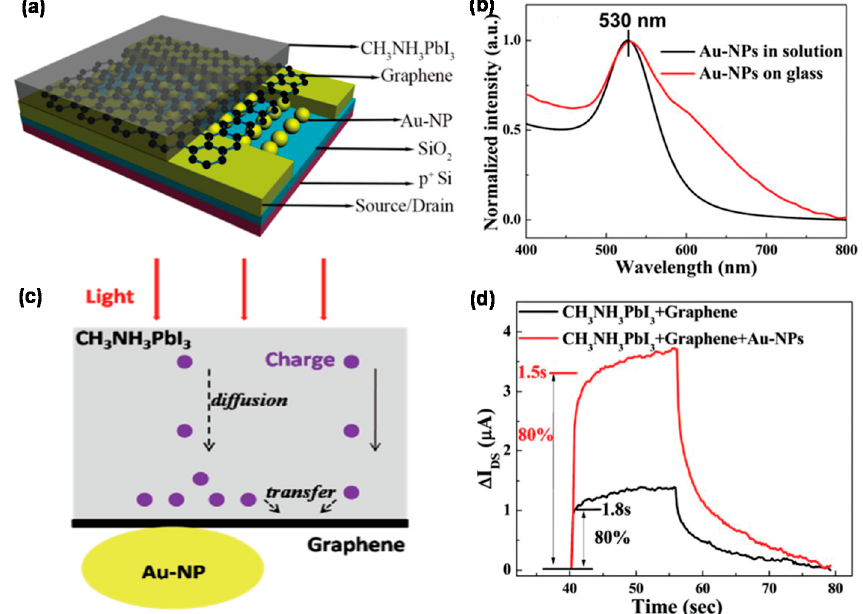
Figure 8. ( a ) Schematic of the CH 3 NH 3 PbI 3 -graphene-Au NP hybrid system device architecture ( b ) UV-Vis absorbance spectrum of Au-NPs on a 3-aminopropyltriethoxysilane-coated glass; ( c ) Schematic of generation, diffusion, and transfer of photo-induced carriers in the perovskite layer with and without the influence of gold NPs; ( d ) Response time study on a single representative light/dark cycle. Reproduced with permission for Figure 8a–d from 2016 Nanoscale